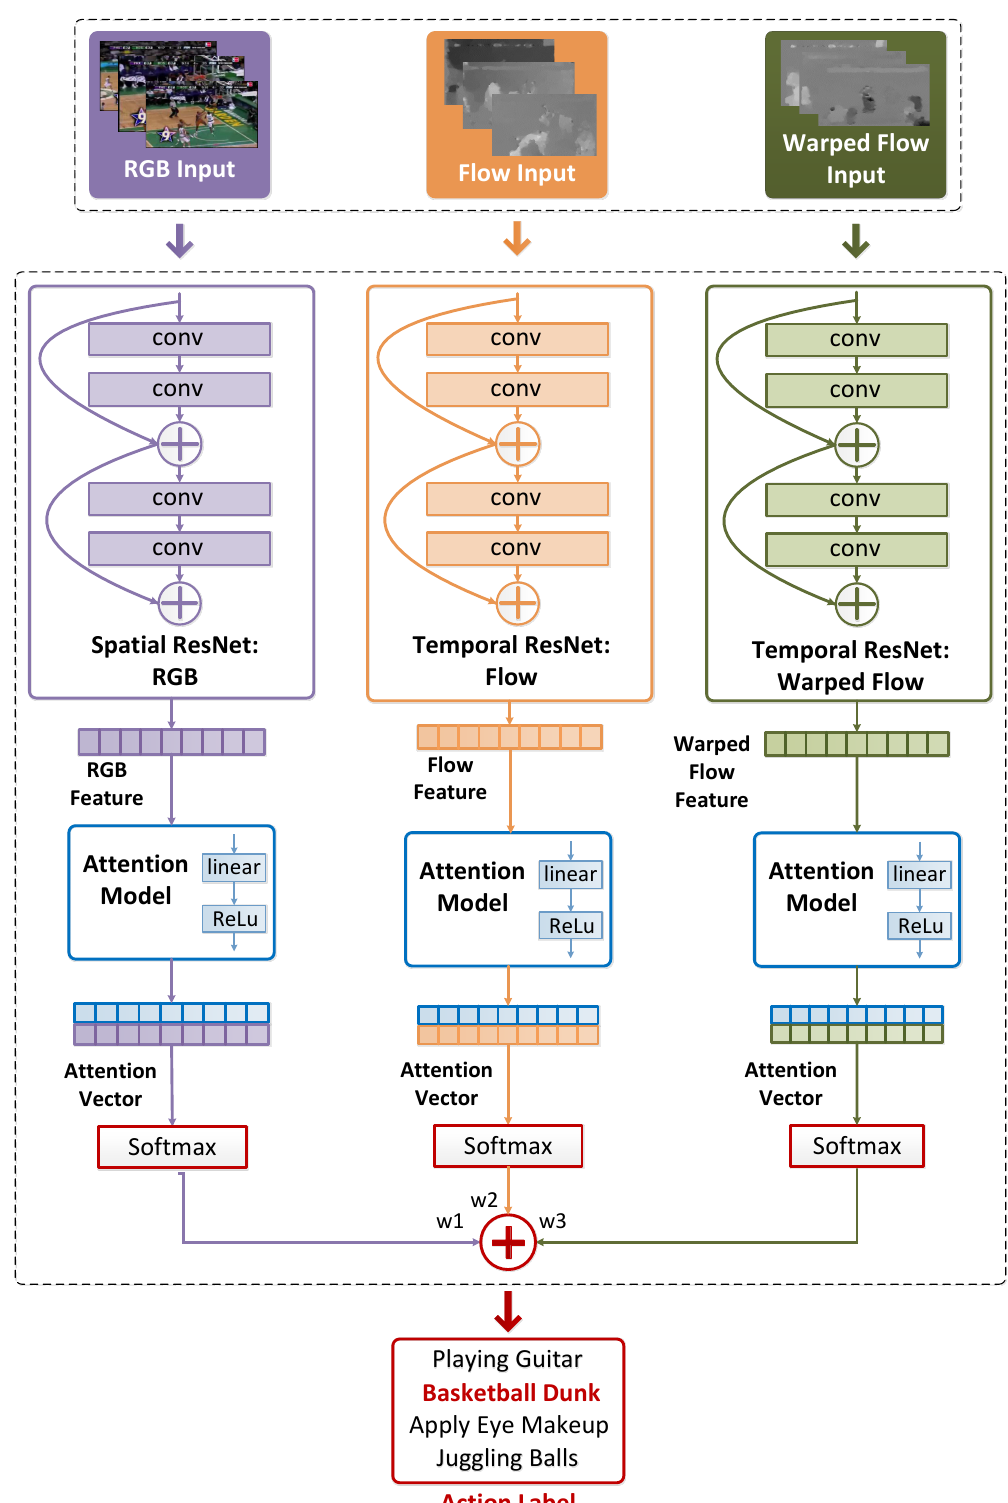
Figure 2. Proposed ATW CNN architecture. Three CNN streams are used to process spatial RGB images, temporal optical flow images, and temporal warped optical flow images, respectively. An attention model is employed to assign temporal weights between snippets for each stream/modality. Weighted sum is used to fuse predictions from the three